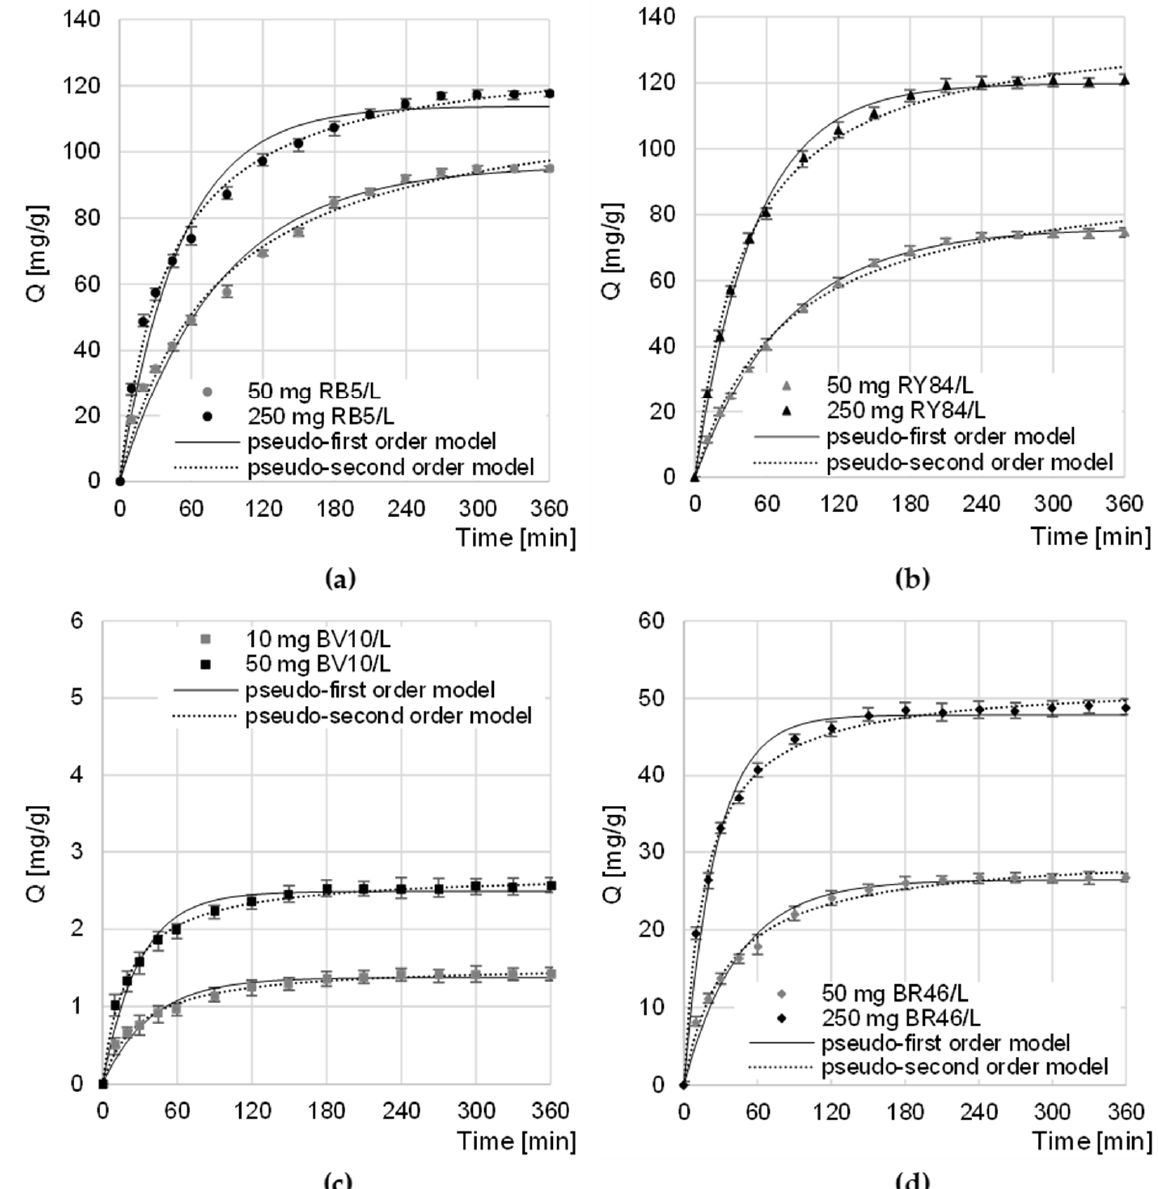
Figure 4. Changes in the concentration of: ( a ) RB5, ( b ) RY84, ( c ) BV10, and ( d ) BR46 during sorption onto CHM. Temp. 22 °C.